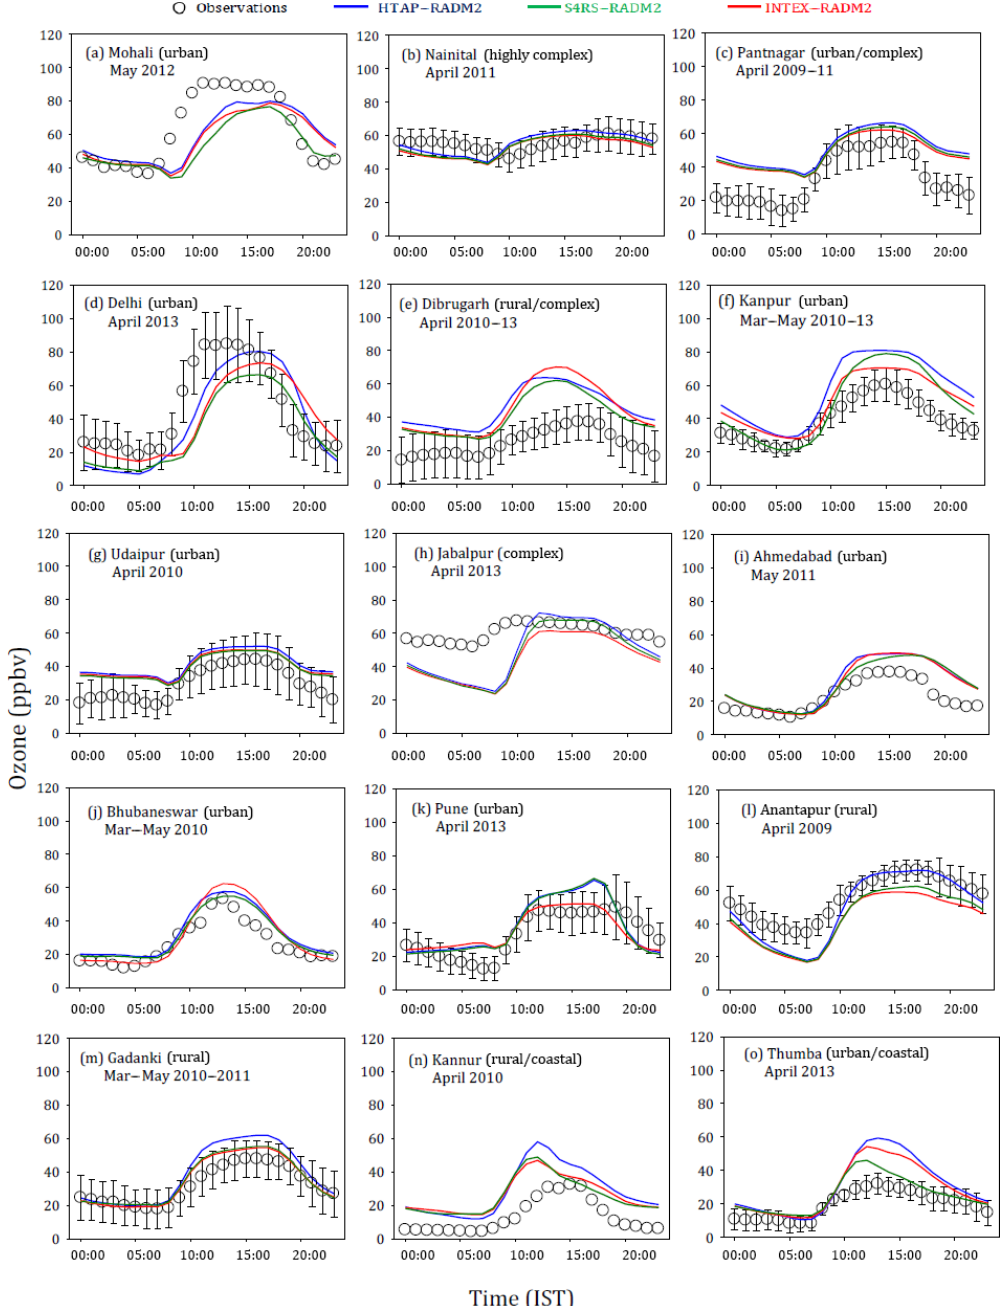
Figure 6. Comparison of monthly average diurnal variation of surface ozone simulated using different emission inventories at various observation sites. The observational data are available for the period indicated in the figure, whereas all model simulations are for the year 2013. Error bars represent the temporal standard deviations (SDs) of the monthly averages. All model simulations are with RADM2 chemistry.